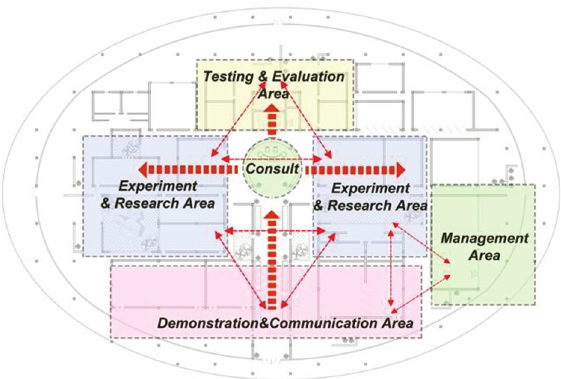
Figure 14: Relationship of function.